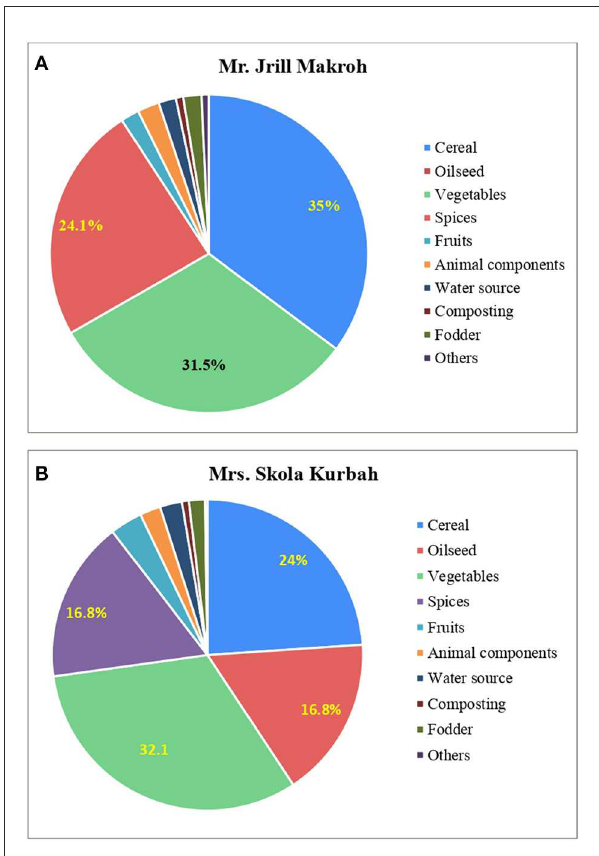
FIGURE4 Allocation of different enterprises in the IOFS models of two farmers in the adopted villages. (A) Mr. Jrill Makroh and (B) Mrs. Skola Kurbah.